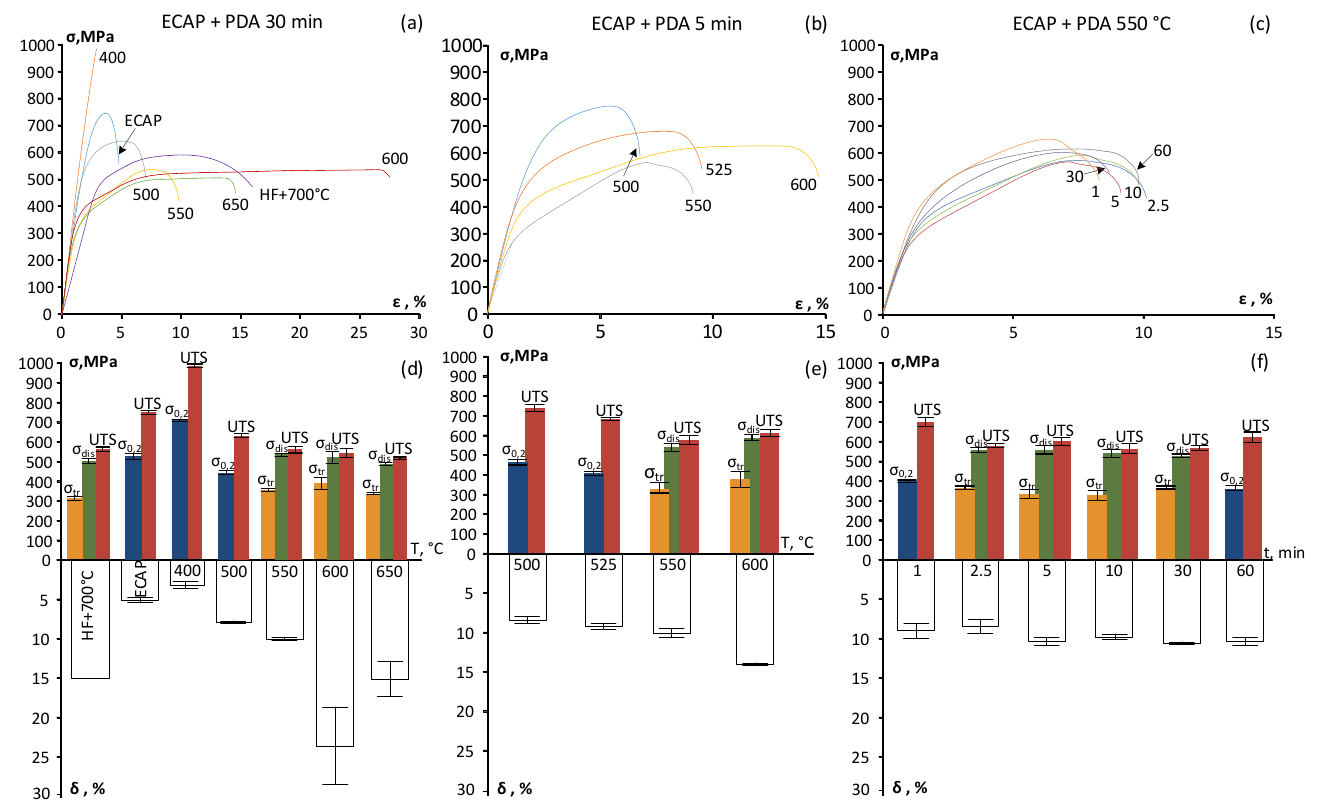
Figure 8. Mechanical characteristics of the Ti–18Zr–15Nb alloy: ( a – c ) stress–strain diagrams; ( d – f ) histograms of the mechanical properties after: ( a , d ) ECAP + PDA (30 min); ( b , e ) ECAP + PDA (5 min); ( c , f ) ECAP + PDA at 550 ° С .